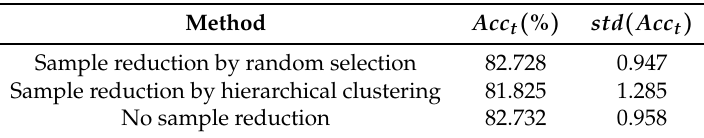
Table 3. Average and standard deviation of test accuracies obtained for the 7-folds of cross-validation experiment on